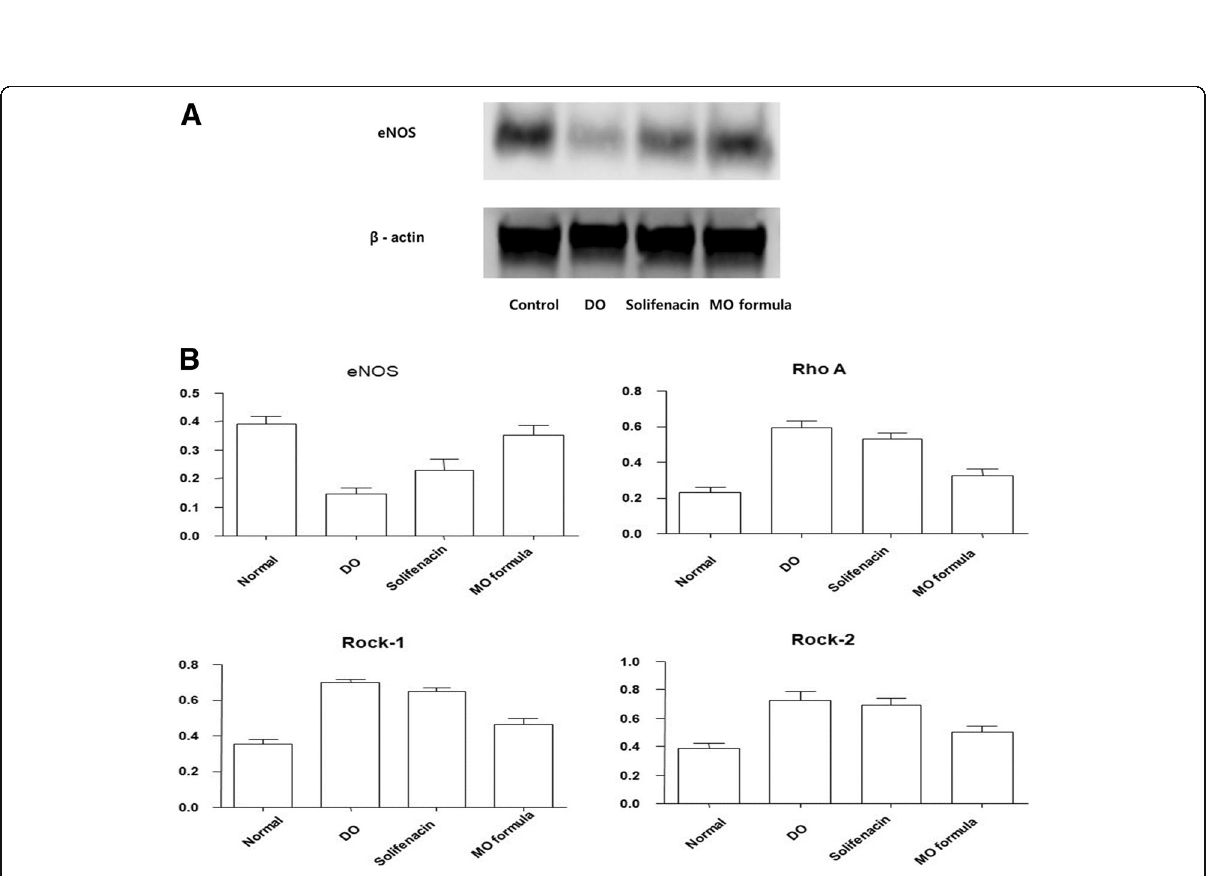
Fig. 4 Nitric oxide related change. a Western blot analysis. b Difference between each group in eNOS, Rho, Rock-1,